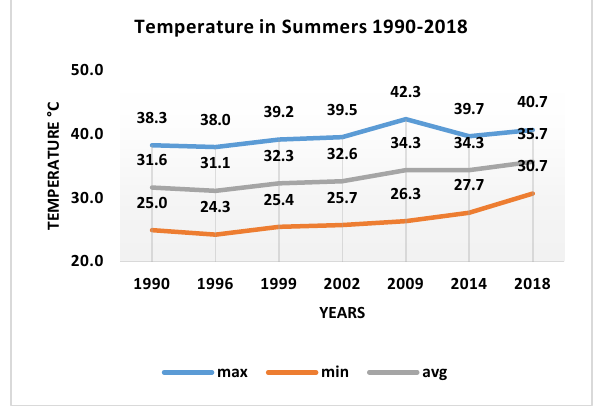
Figure 16. Summer Temperature from 1990-2018